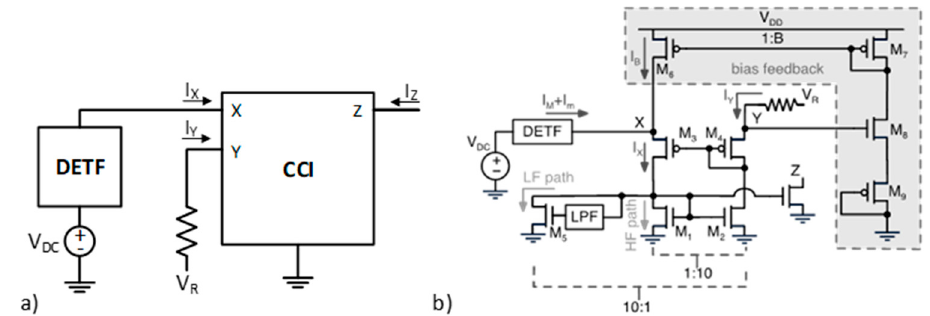
Figure 2. ( a ) Block scheme of the oscillator-based strain sensor composed of DETF and CCI readout amplifier. ( b ) Schematic of the class-A